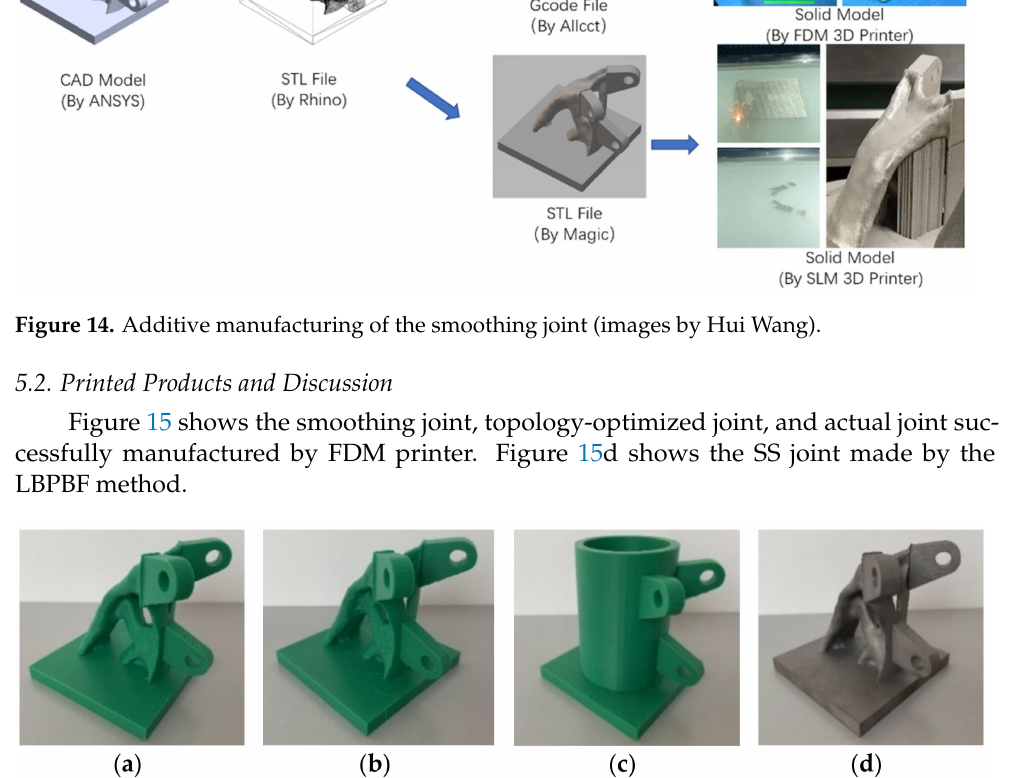
Figure 15. Solid models printed by a 3D printer: ( a ) smoothing joint; ( b ) topology-optimized joint; ( c ) actual joint; ( d ) LBPBF smoothing joint (Images by Hui